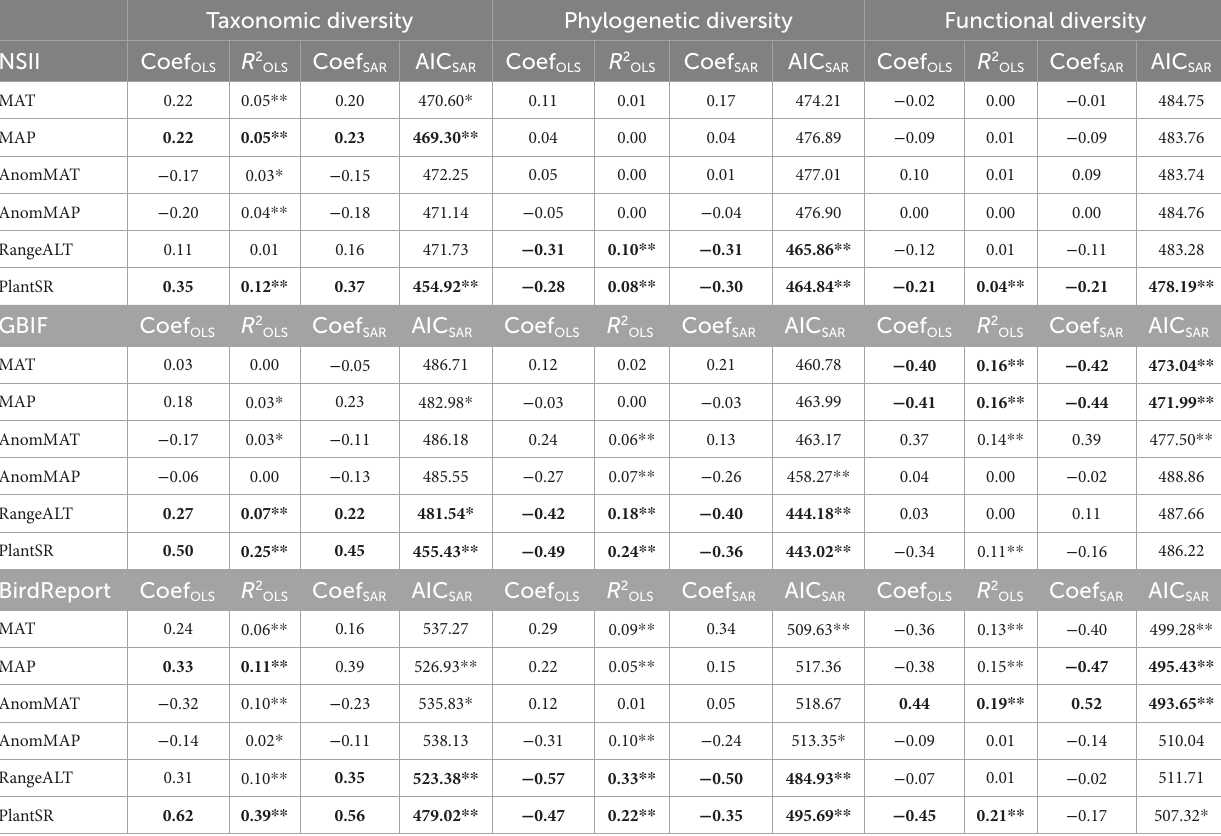
TABLE 3 Correlation coefficients between the diversity indices and environmental factors in each dataset in the observational dataset. Taxonomic diversity Phylogenetic diversity Functional